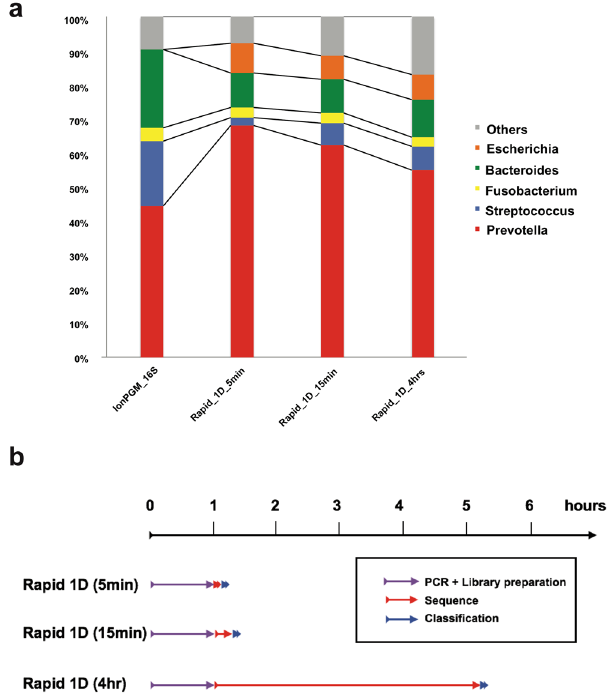
Figure 4. Clinical application of our system for determining bacterial composition in a pleural effusion from a patient with empyema. ( a ) Pleural effusion sample sequenced using three different methods indicating that Prevotella was the predominant bacteria. ( b ) Timescale for the experiment. Flow cell preparations took ~20 min for quality check and priming, which can be done during the PCR.